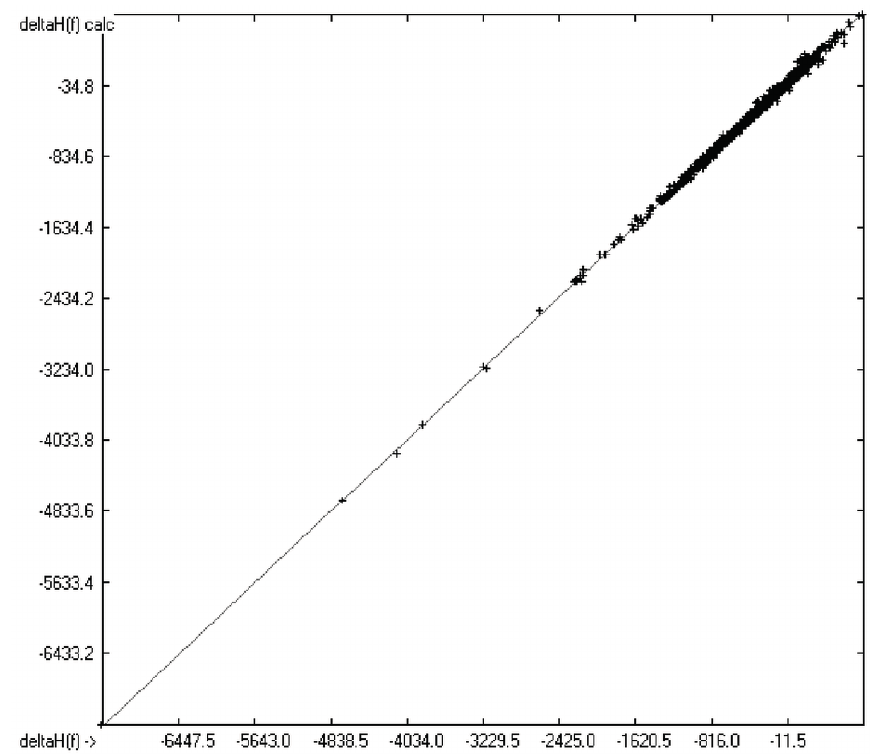
Figure 3. Correlation diagram of heat-of-formation data (N = 2031, R 2 = 0.9974, slope =